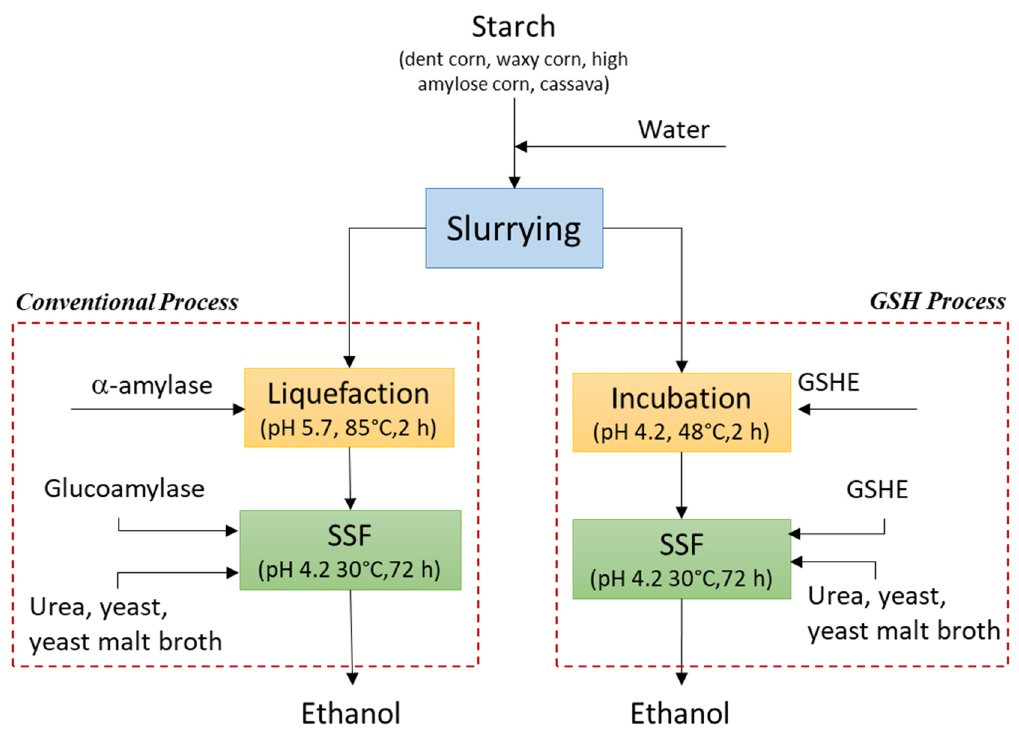
Table 1. Comparison of normal corn starch and cassava starch [17].